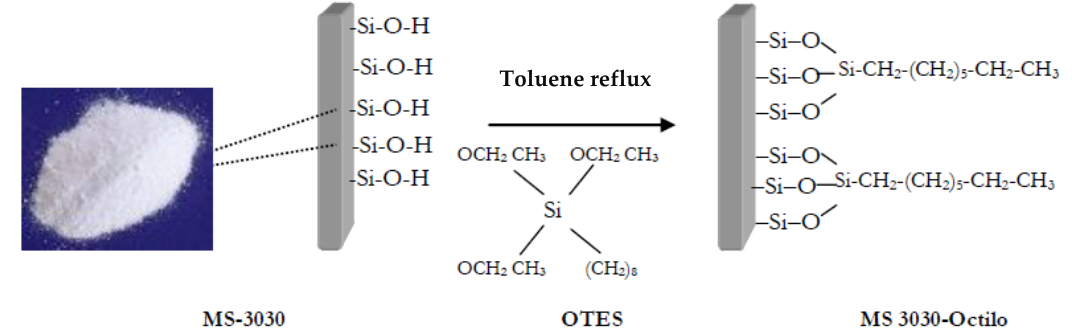
Figure 5. Functionalization of commercial MS-3030 by anchoring an octyl group, through silanization reaction of the surface silanol groups, with the organosilane octyl-triethoxysilane, OTES.